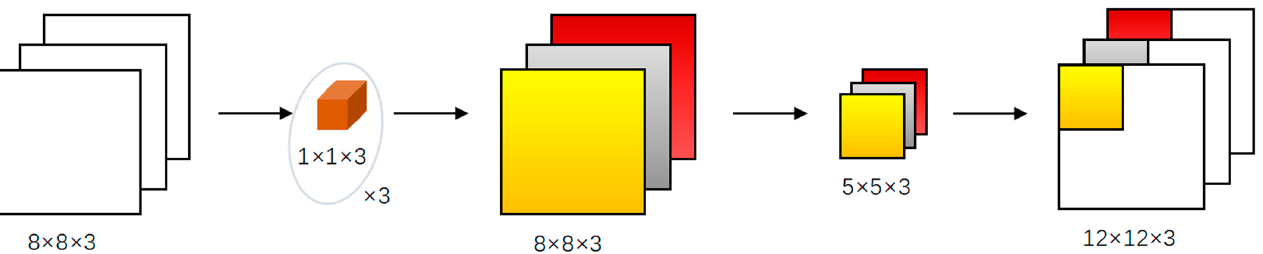
Figure 1. Schematic diagram of deep separable deconvolution.